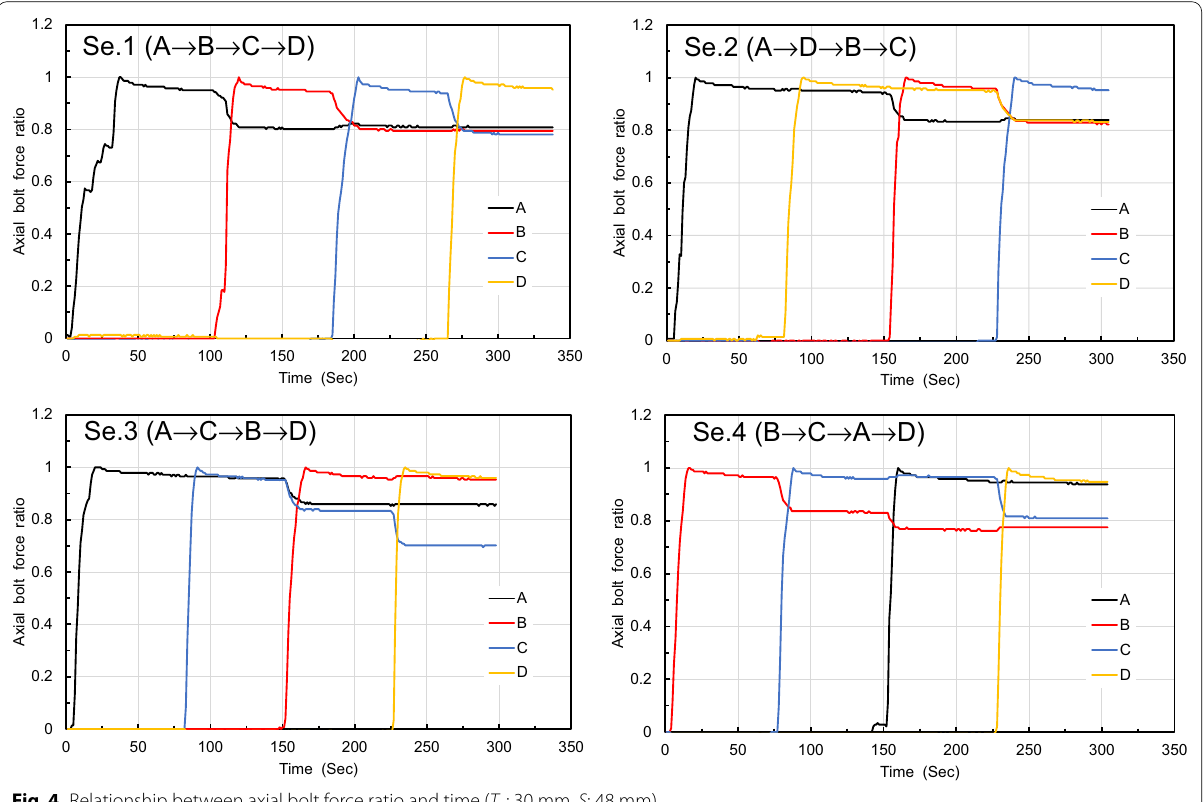
Fig. 4 Relationship between axial bolt force ratio and time ( T h : 30 mm, S : 48